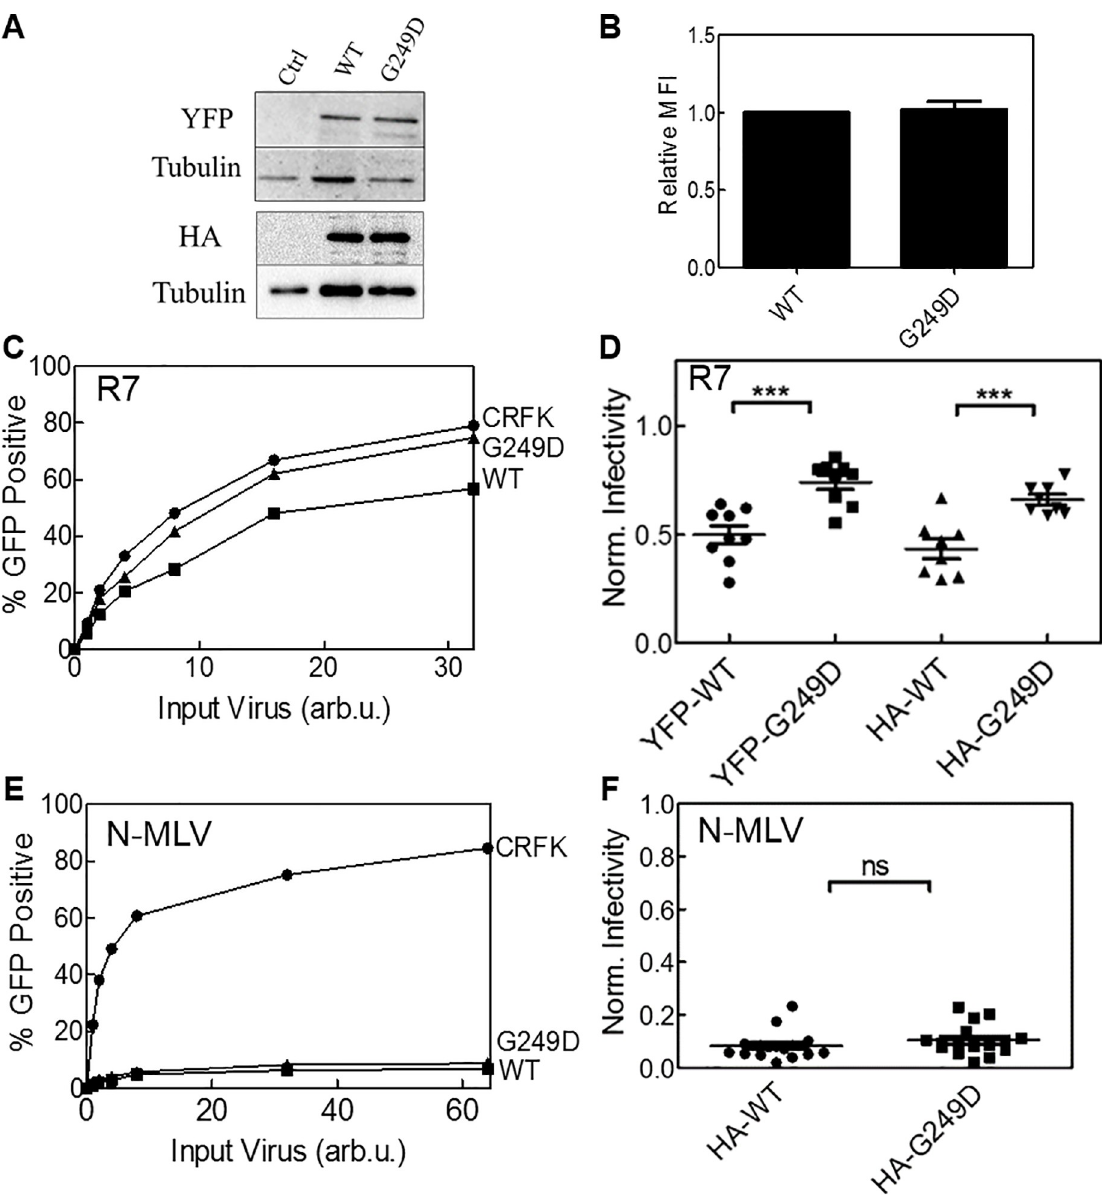
Fig 1. The G249D polymorphism of huTRIM5 α exhibits reduced restriction of HIV-1 but not N-MLV. CRFK cells transduced to stably express YFP and HA tagged human TRIM5 α . (A) Protein expression of YFP and HA tagged human WT, G249D TRIM5 α and untransduced (control) cell lines by immunoblot. Tubulin used as a loading control. (B) Relative mean fluorescence intensities of WT and G249D TRIM5 α by flow cytometry. Error bars represent SEM of 5 biological replicates. (C) Equivalent number of CRFK cells infected by R7 Δ EnvGFP or N-MLV (E) by a serial of dilutions. Percent GFP positive cells quantified by flow cytometry 48 hours post infection. (D and F) Normalized infectivity for cell lines expressing YFP and HA tagged human WT, G249D TRIM5 α . Normalization done by using percent GFP positive cells of untransduced cell line for virus concentrations resulting less than 35% infectivity (p < 0.05 compared to the WT). compared by infecting equivalent number of CRFK cells with HIV-1 GFP reporter virus pseu- dotyped with VSV-G envelope. The percent GFP positive cells were obtained by flow cytome-